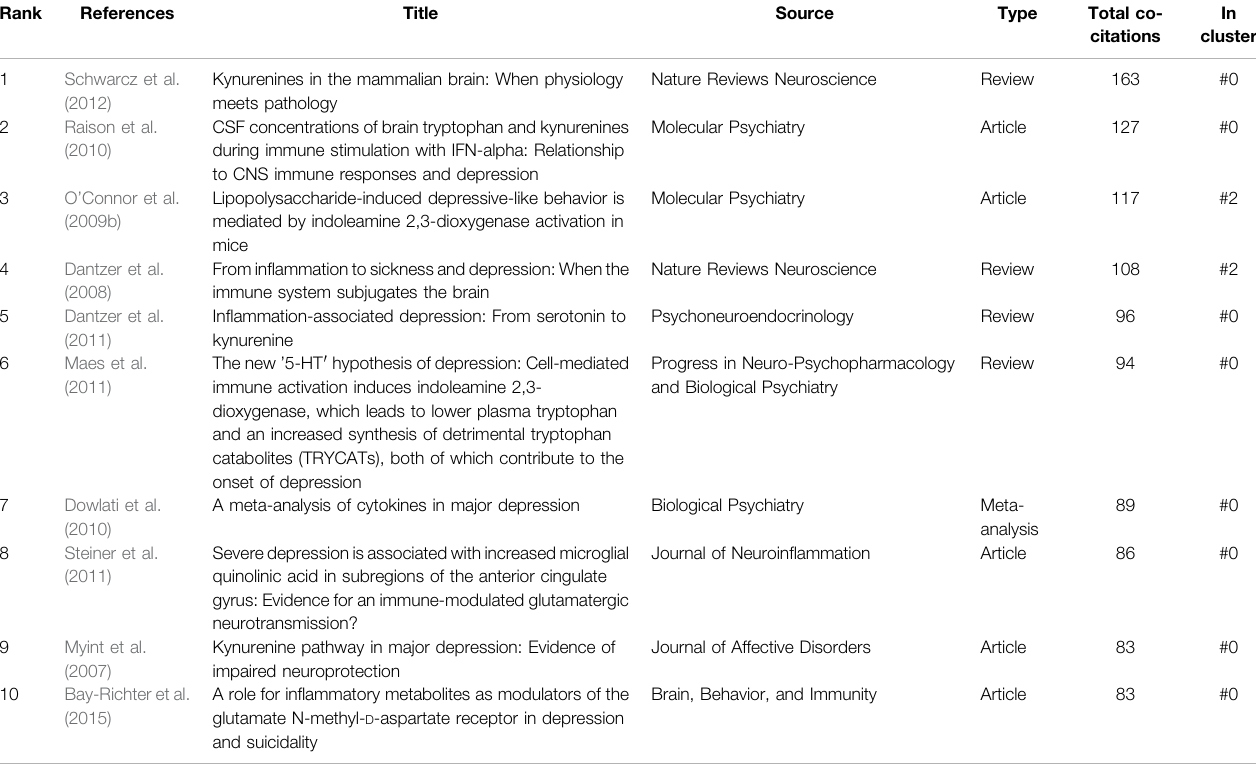
TABLE 3 | The top ten co-cited references related to the kynurenine pathway (KP) in mood disorders between 2000 and 2020. Rank